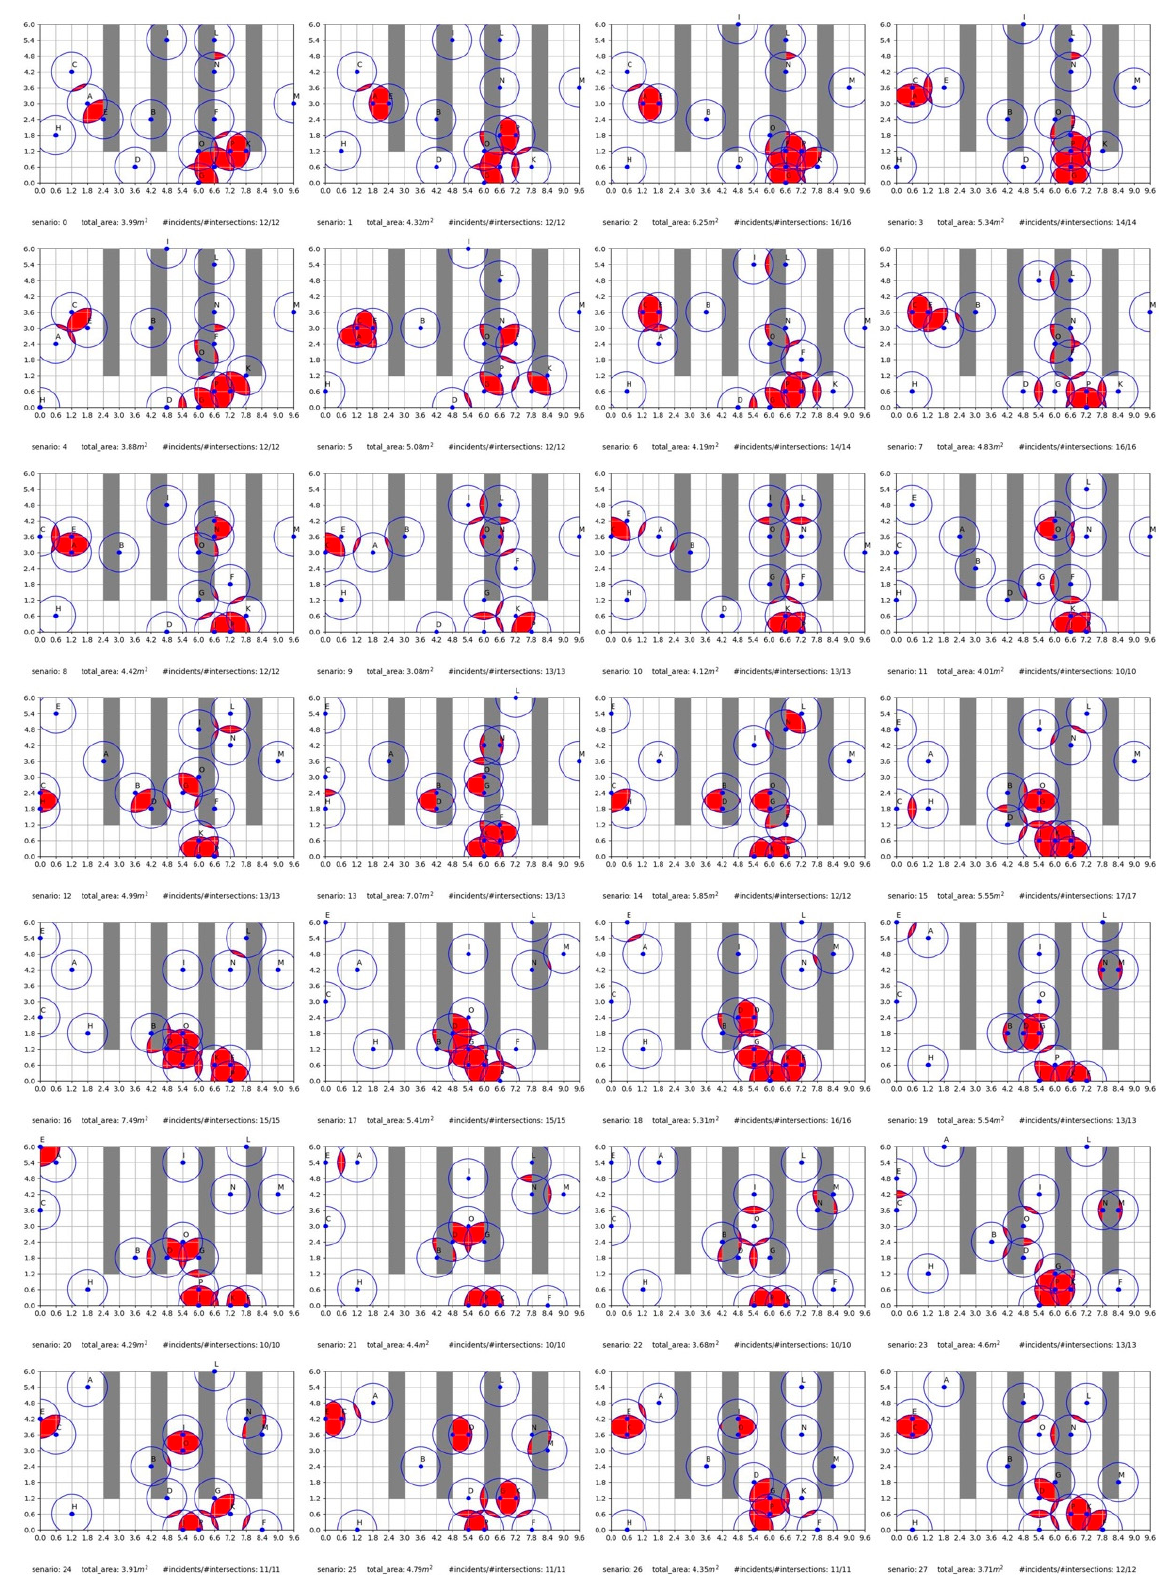
Figure 6. Graphic output showing simulated occupant positioning with the furniture layout for teaching and learning activity 4 (individual work), without contact time consideration.